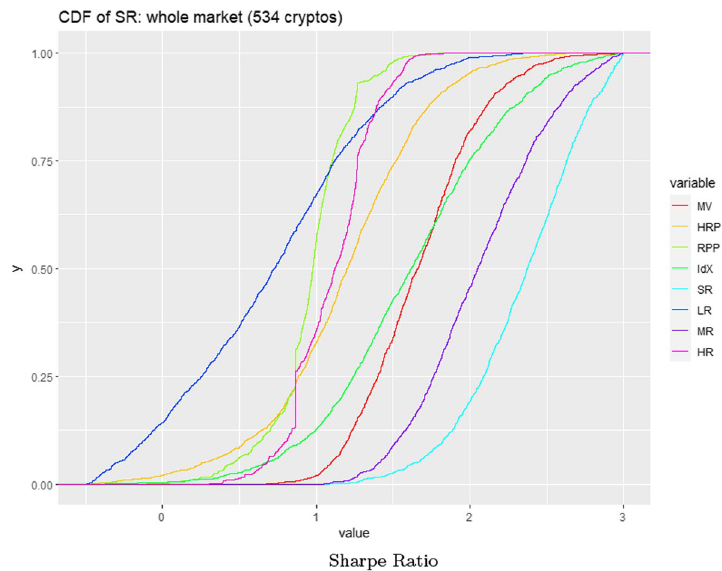
Fig. 7 Cumulative distribution of annualized sharpe ratio ( SR ann ) of the simulations (1500 random investing paths) for the whole